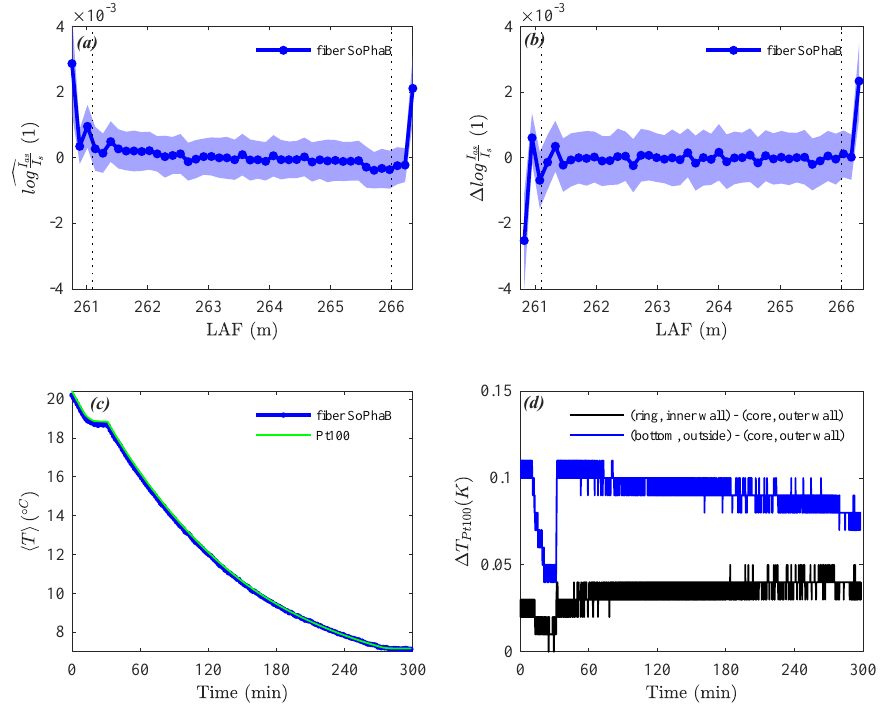
Figure 3. Solid-Phase Bath (SoPhaB) performance from the cooling “Windtunnel” evaluation: Tempo- ral average (solid line with markers) and ± standard deviation (band) of the ( a ) spatial perturbation of the ratio of Raman backscatter intensities, and ( b ) their approximate finite differences between adjacent fiber-optic measurement bins. Time series of the ( c ) spatially averaged fiber-optic and refer- ence (Pt100) temperatures, and ( d ) spatial reference (Pt100) temperature differences across several locations at measurement resolution of 0.01 K. The vertical dotted lines mark the beginning and end of the reference section over which the spatial average was